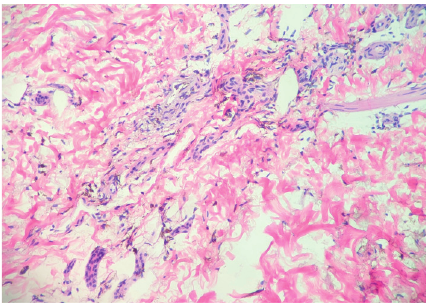
Figure 4: Intermediate magnification shows coarse cytoplasmic granular brown pigmentation within aggregates of macrophages surrounding eccrine structures in the dermis (200x; hematoxylin and eosin staining).